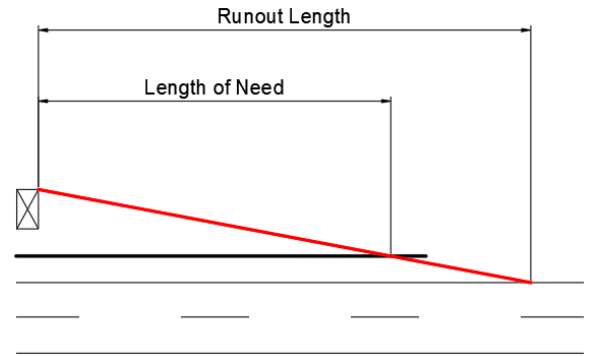
Figure 4 . Minimum length of need for guardrail.